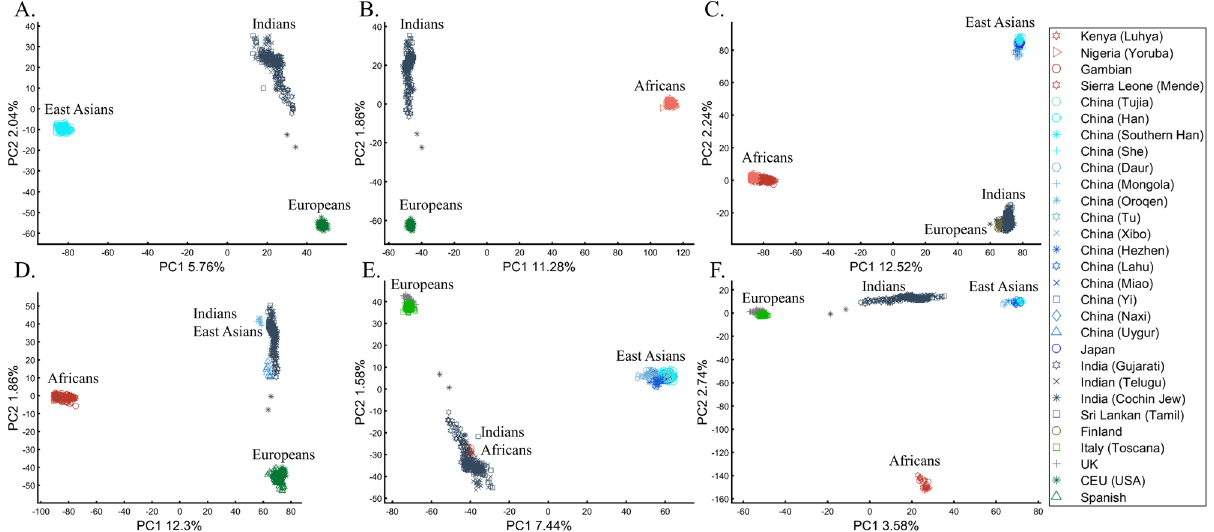
Figure 5. Studying the origin of Indians using PCA. ( A ) Replicating Reich et al.’s 45 results using n Eu = 99; n As = 146; n Ind = 321. Generating alternative PCA scenarios using: ( B ) n Af = 178; n Eu = 99; n Ind = 321, ( C ) n Af = 400; n Eu = 40; n As = 100; n Ind = 321, ( D ) n Af = 477; n Eu = 253; n As = 23; n Ind = 321, ( E ) n Af = 25; n Eu = 220; n As = 490; n Ind = 320, and ( F ) n Af = 30; n Eu = 200; n As = 50; n Ind =